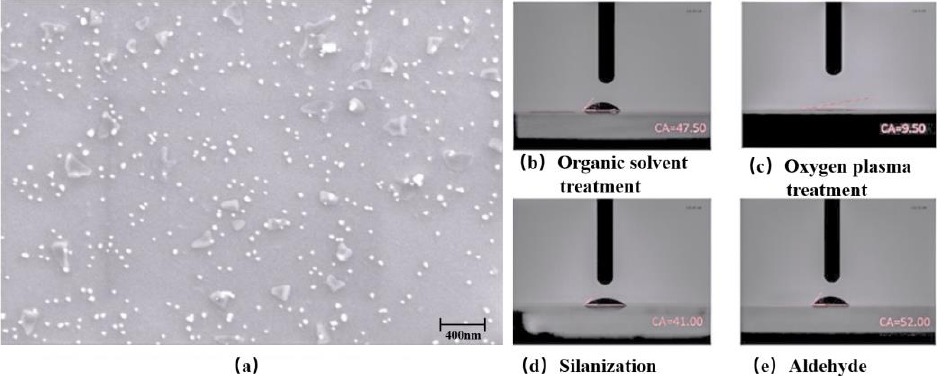
Figure 4. ( a ) SEM image of AuNPs with the magnification of 25,000 × . Contact angles of the sensor surface after ( b ) organic solvent treatment, ( c ) oxygen plasma treatment, ( d ) salinization and ( e ) aldehyde treatment.